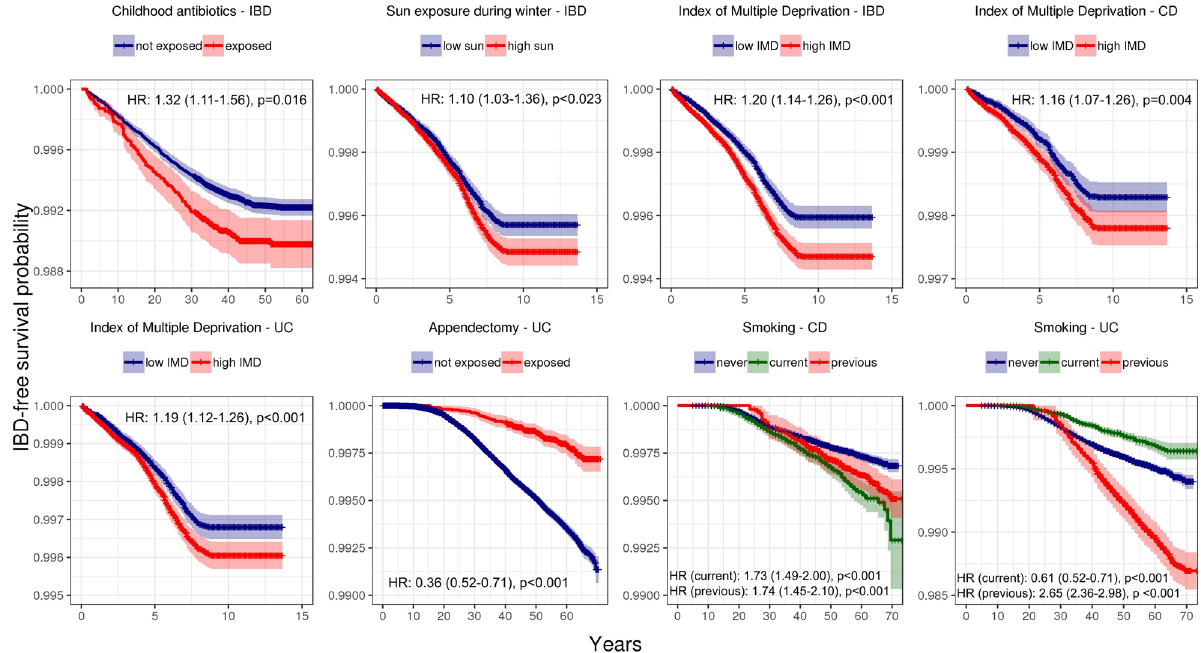
Figure 6. Kaplan–Meier curves for the statistically significant (FDR < 0.05 in Cox regressions conditional on polygenic risk and other covariates) environmental variables with IBD diagnosis as the event. Shading indicates 95% confidence interval. For IMD, hazard ratios are given per standard deviation of the variable. IMD = Index of Multiple Deprivation.